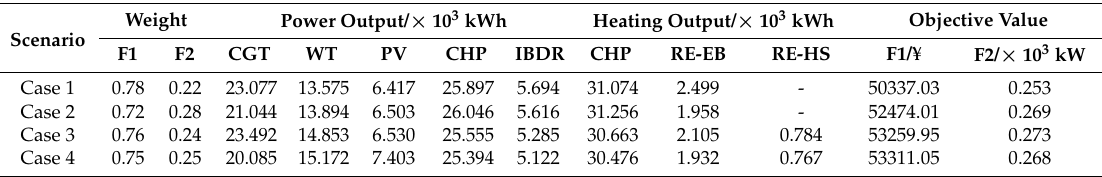
Table 4. HES scheduling optimization results for different